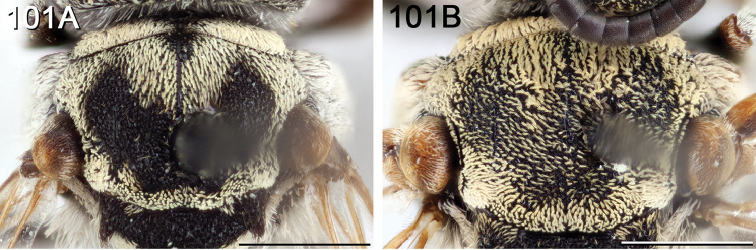
Mesoscutal pubescence (dorsal view) in males of E.
minimus
A as paramedian bands joined apically and B entirely obscuring the integument. Scale bars 1 mm.